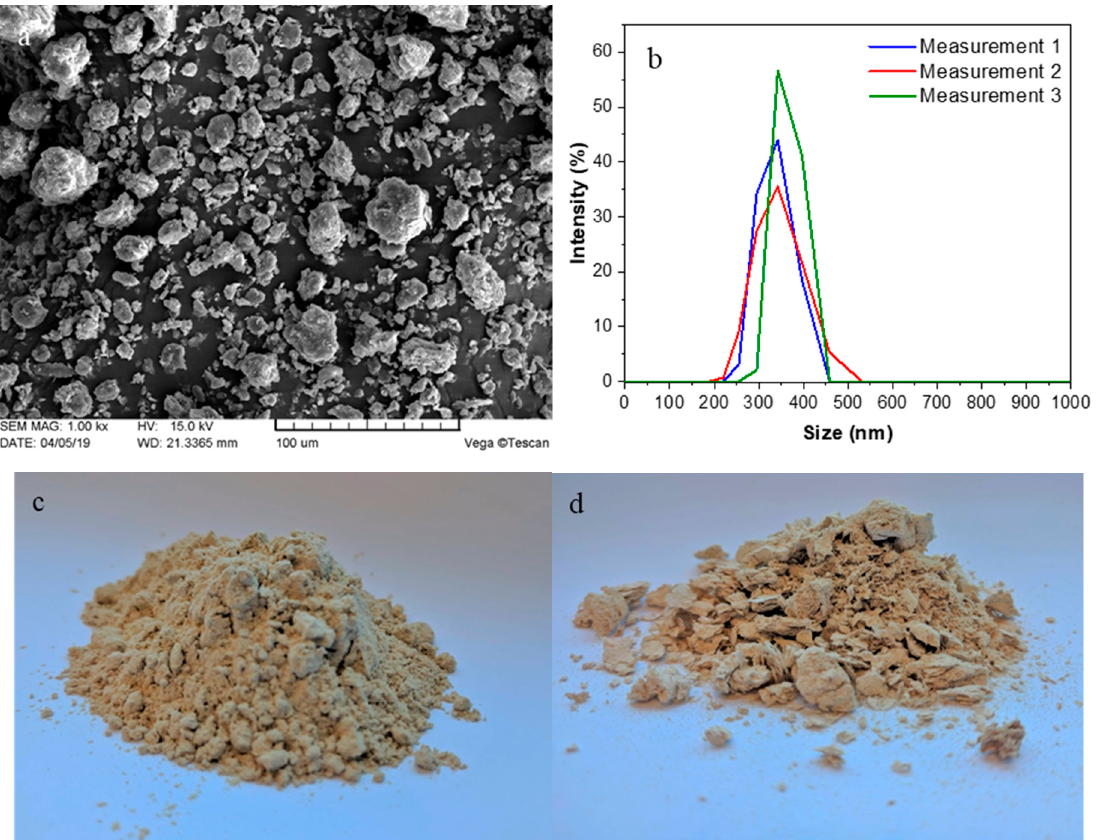
Figure 1. ( a ) Scanning electron microscopy micrograph of microcrystalline cellulose (MCC); ( b ) dynamic light scattering analysis of nanofibrillated cellulose (NFC); ( c ) dry MCC filler and ( d ) freeze-